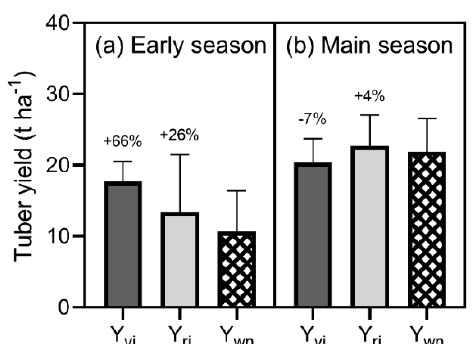
Figure 5. Effect of different irrigation strategies on the early ( a ) and main ( b ) season potato yields (Y vi , vegetative-stage-irrigated yield; Y ri , reproductive-stage-irrigated yield; Y wn , water- and nitrogen-limited yield). Values above error bars indicate the effects of irrigations. Error bars indicate standard deviation over the years.